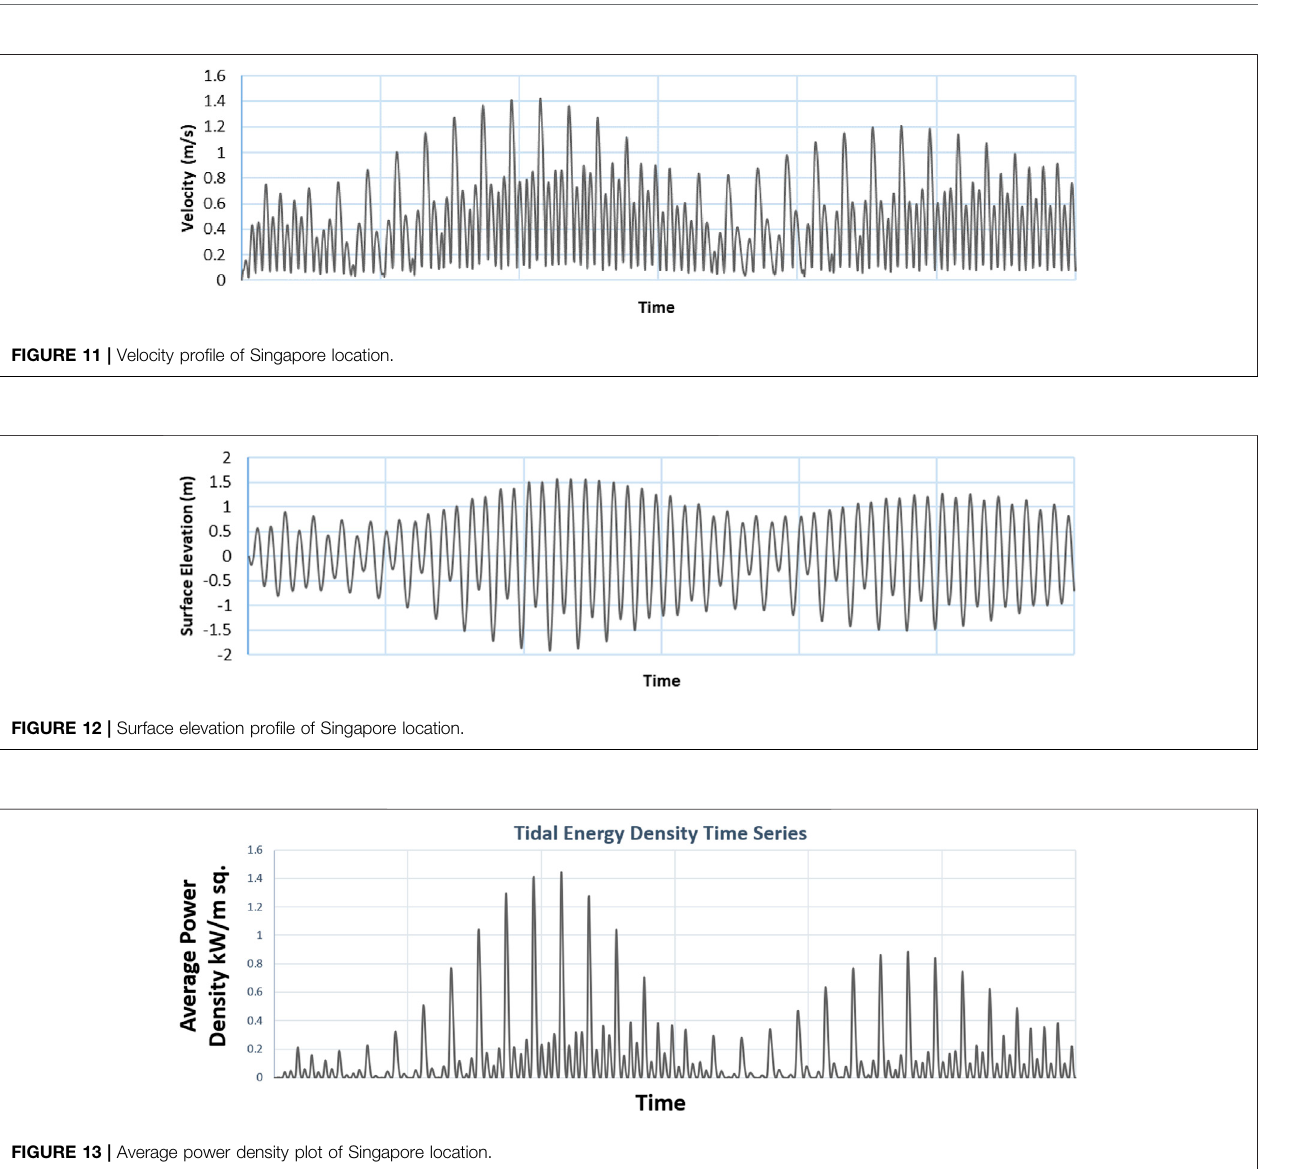
FIGURE 13 | Average power density plot of Singapore